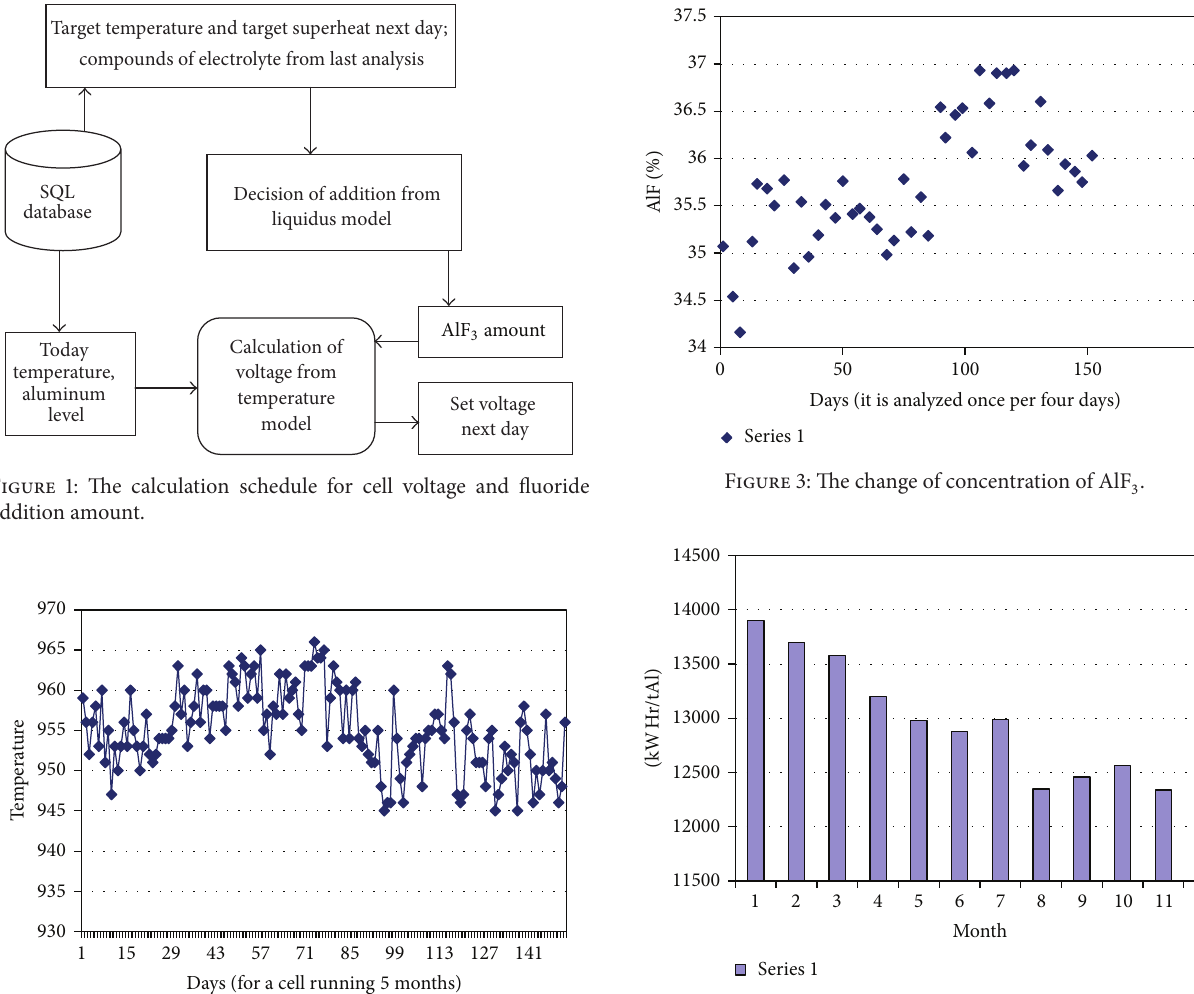
Figure 4: Energy consumption change for the system running 12 months (all four test